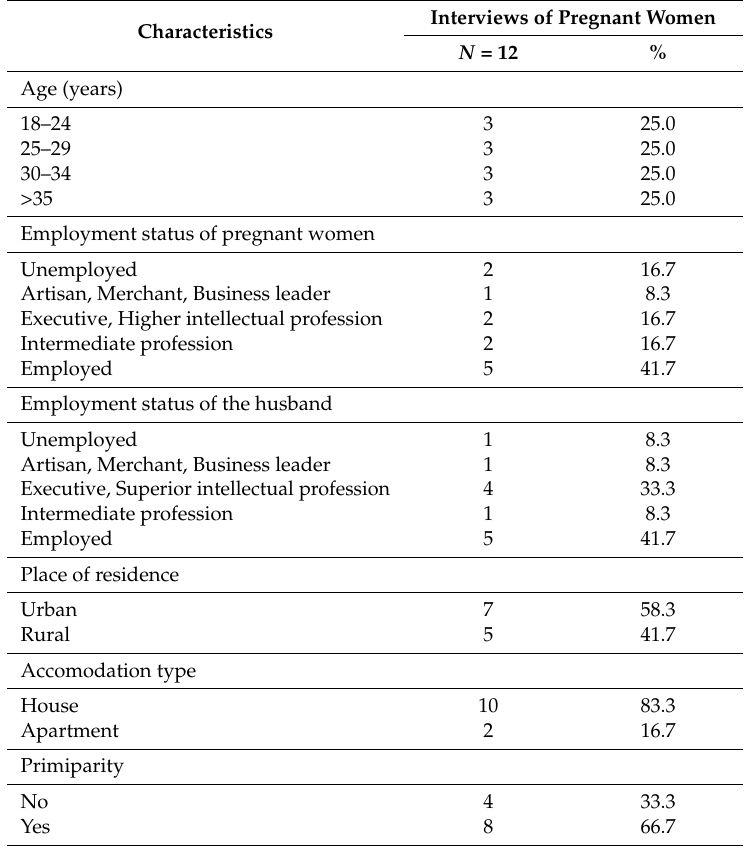
Table A1. Characteristics of semi-structured individual interview participants.